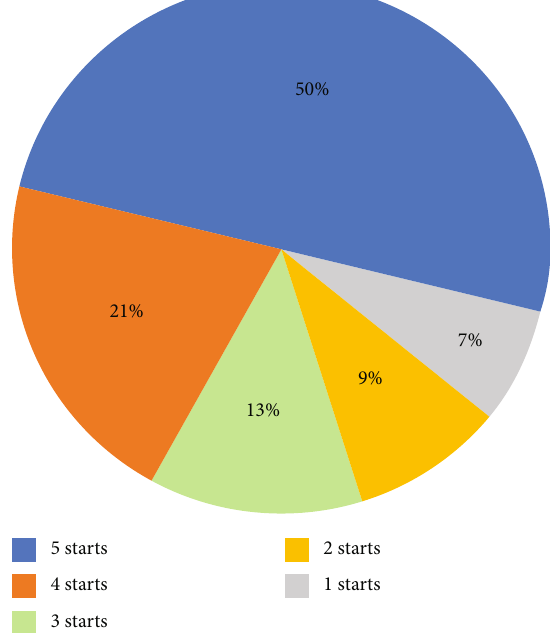
Figure 10: Graph of website users ’ ratings of four digital art